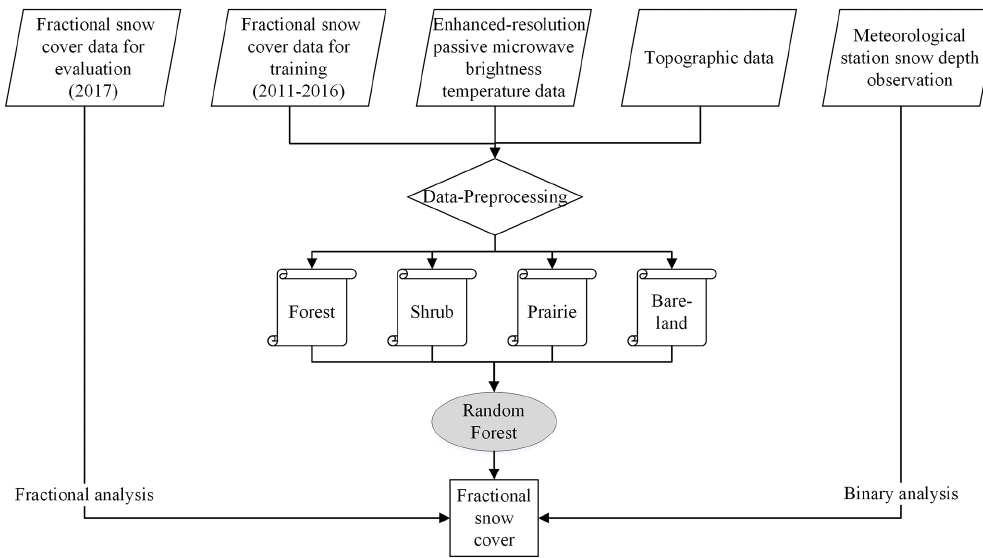
Figure 2. Workflow diagram illustrating the processing of fractional snow cover retrieval.